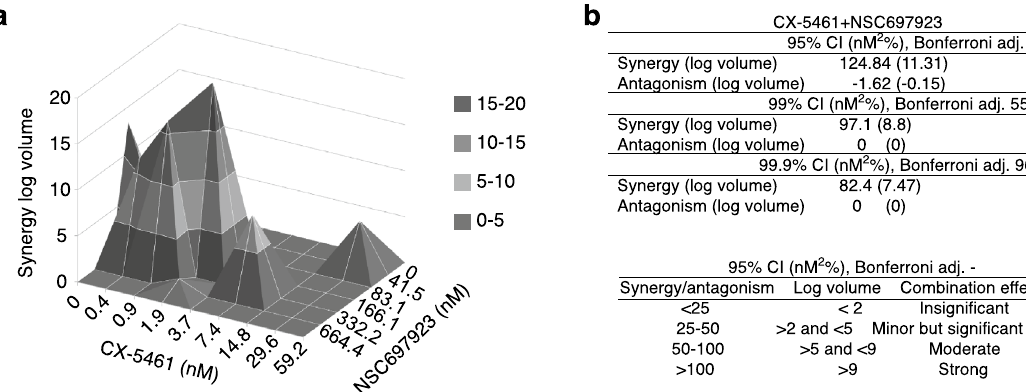
Figure 5. Pharmacological inhibition of UBE2N acts synergistically with CX-5461. ( a ) HCT116 cells were treated with serial dilutions of NSC697923 and CX-5461, as individual dilutions or as drug mixtures in 45 combinations, using equipotency ratios, for four days. NSC697923 was added at five doses and CX-5461 at nine. In the end, WST-1 assay was performed and results were analyzed to determine drug synergy using MacSynergyII software. The plot represents the volume of synergy produced by the drug combination. Cells with zero volume indicate additive interaction. A peak above zero is synergy, and depression below zero is antagonism. The index indicates the magnitude of the effect. ( b ) The table on the top right shows synergy or antagonism with log volumes in parentheses, at 95%, 99%, and 99.9% confidence intervals (CI) calculated with the indicated Bonferroni adjustment. The table on the bottom right shows the statistically significant cut-offs for synergy and log volumes for the combination effect. The results are representative of two independent experiments with three technical replicates for each